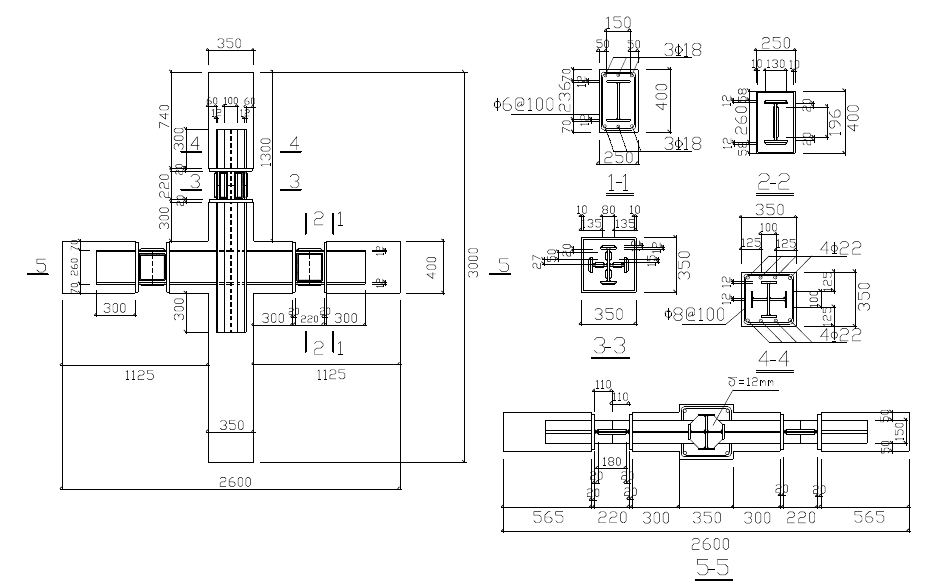
Figure 4. Schematic diagram of reinforcement bars and steel plates of the PPSRC beam–column joint. (Unit: millimeters) The loading apparatus of the exterior and interior beam–column joints are shown in Figure 5.